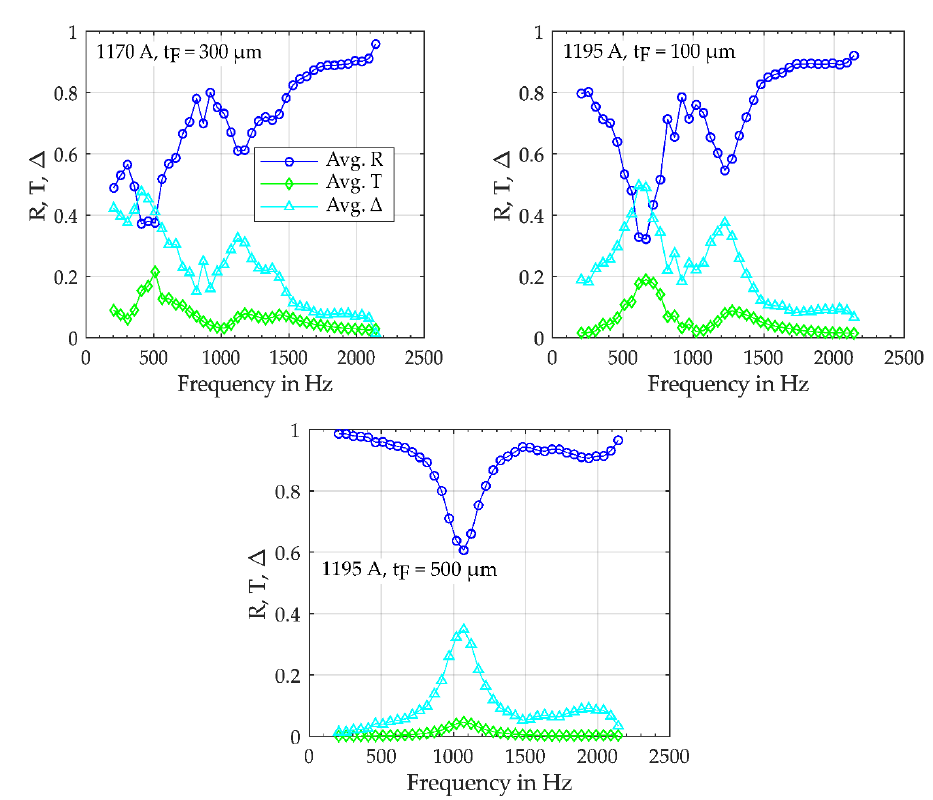
Figure 9. Vibration characteristics of flexible walls.